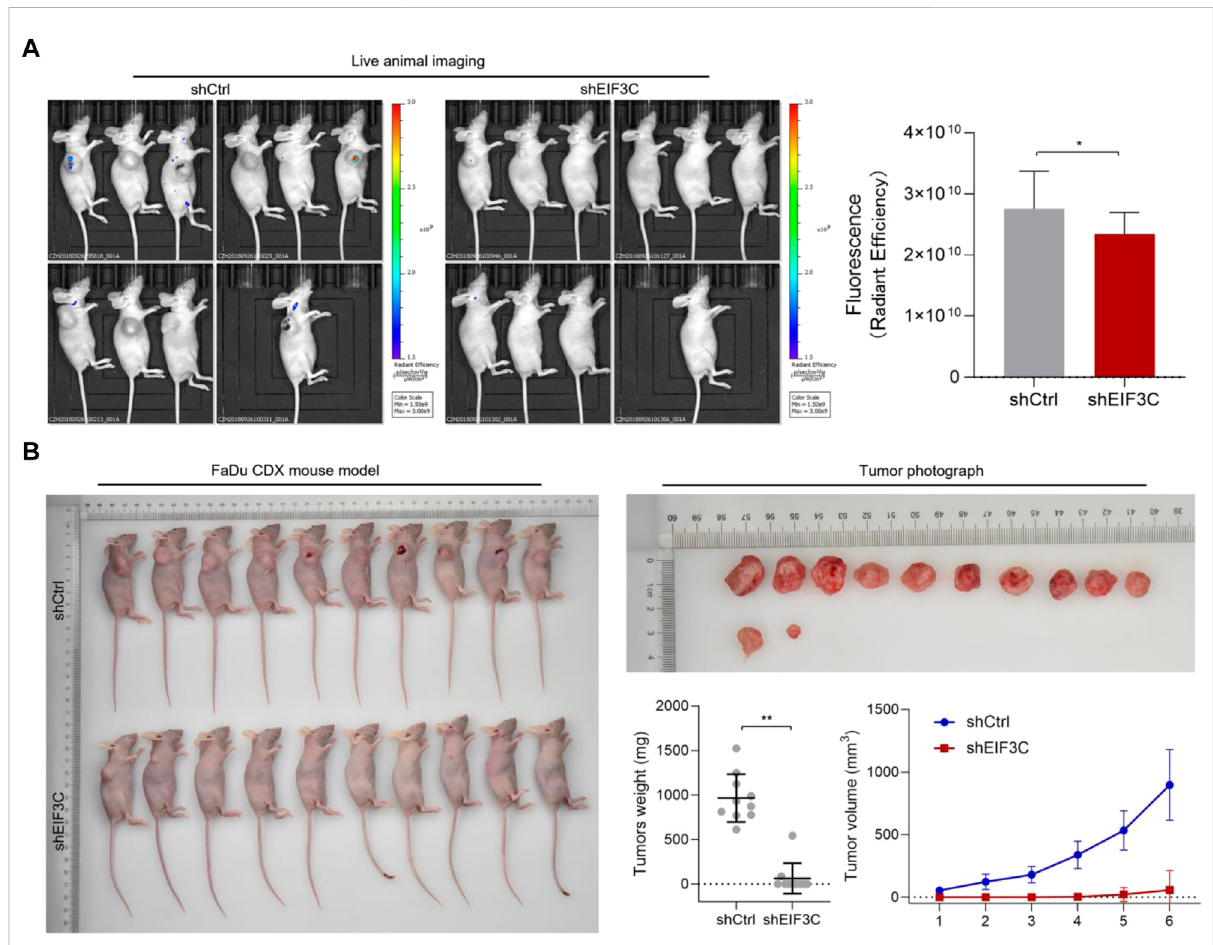
FIGURE 6 L.v-shEIF3C suppressed tumorformation inaFaDucancercell xenograft animalmodel. (A) live animalimagingimages andtheanalysis showed thatthe fl uorescenceintensityoftumorintheL.v-shCtrlgroupwashigherthanthatinL.v-shEIF3Cgroup. (B) Thephotosofmiceandtumors,aswell as tumor weight and size statistics showed that the tumors were small in size and low in weight in L.v-shEIF3C group compared with the L.v-shCtrl group. The data is the means ± SDs. The differences were statistically signi fi cant. * p < 0.05, ** p <